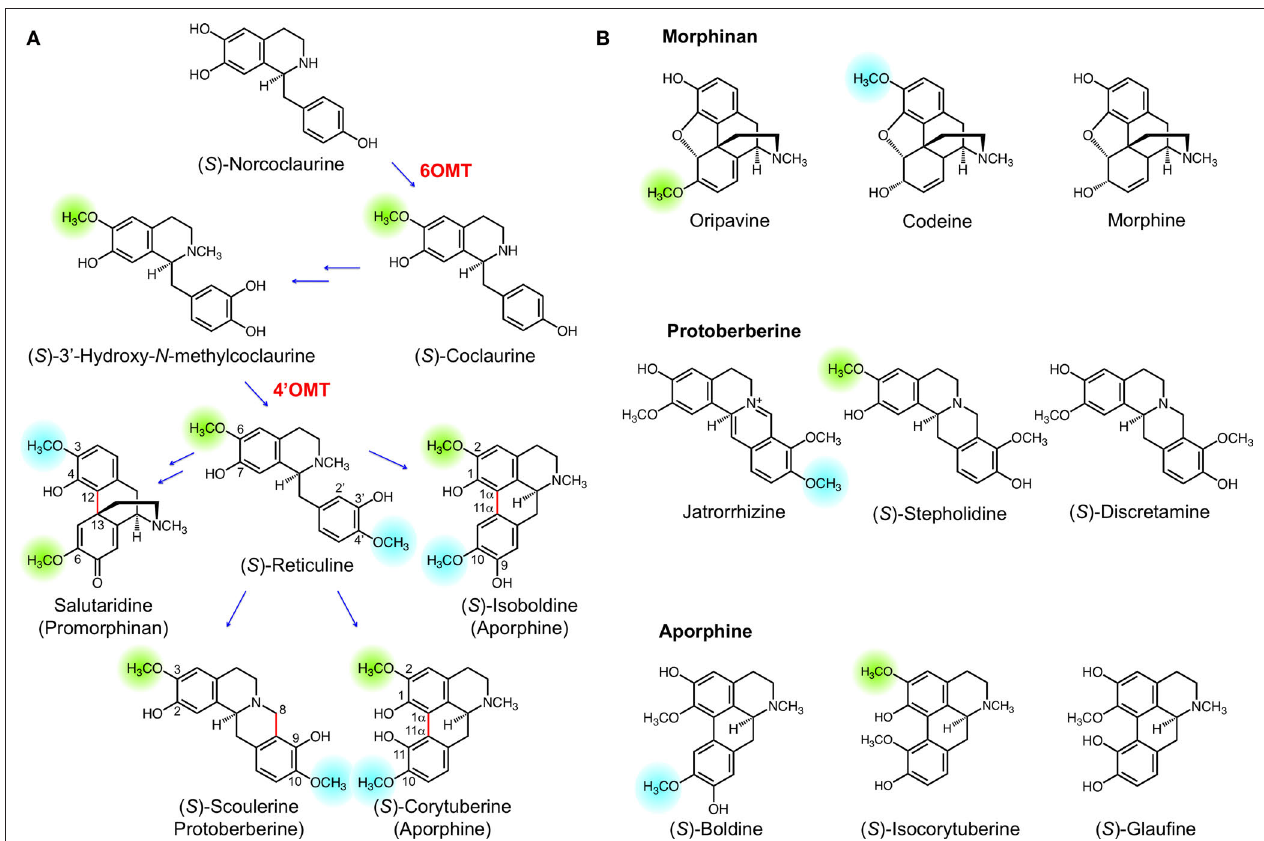
FIgure 3 | (A) Benzylisoquinoline alkaloid (BIA) biosynthesis begins with (S)-norcoclaurine, which acquires two O -methyl groups en route to the central intermediate (S)-reticuline. Intramolecular rearrangement of ( S )-reticuline yields a variety of skeletal structures including promorphinan (e.g. salutaridine), protoberberine (e.g. ( S )-scoulerine), and aprophine (e.g. ( S )-corytuberine and